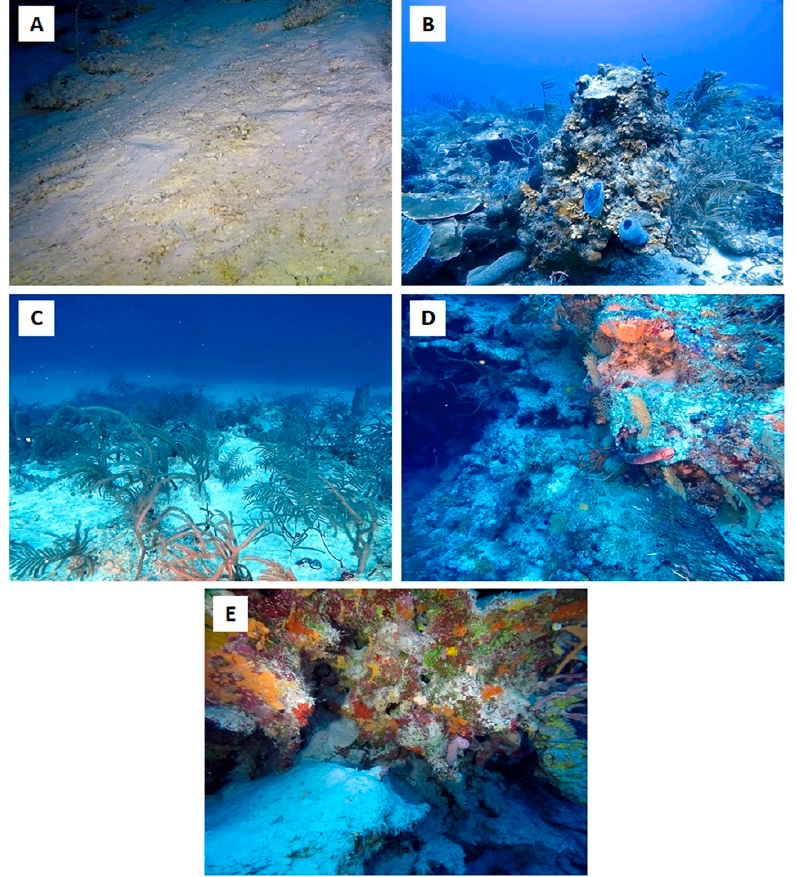
Figure 7. Ecological units on the Mesophotic Coral Ecosystems at the western side of San Andrés